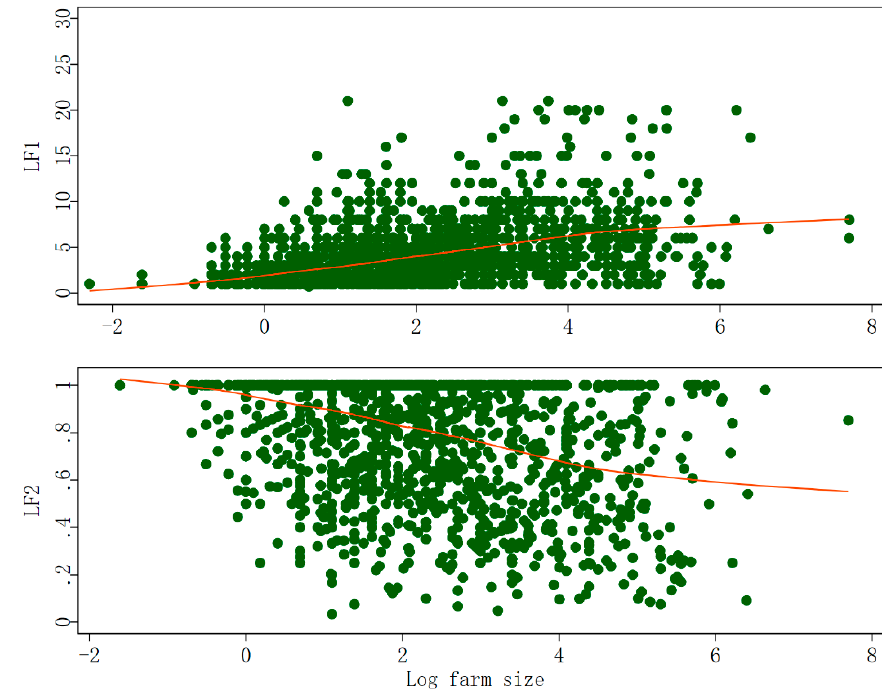
Figure 2. Relationship between farm size and land fragmentation (Bandwidth =